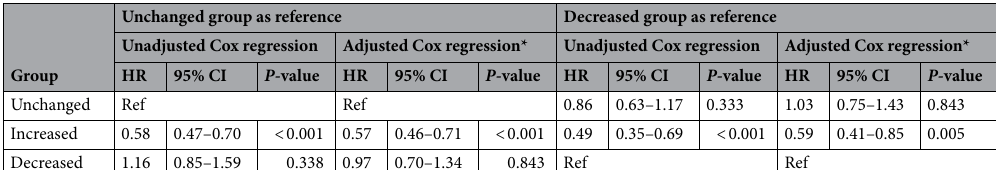
Unchanged group as reference Decreased group as Group